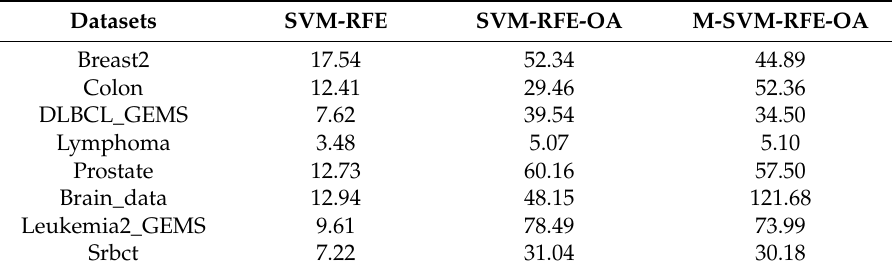
Table 5. The average number of features